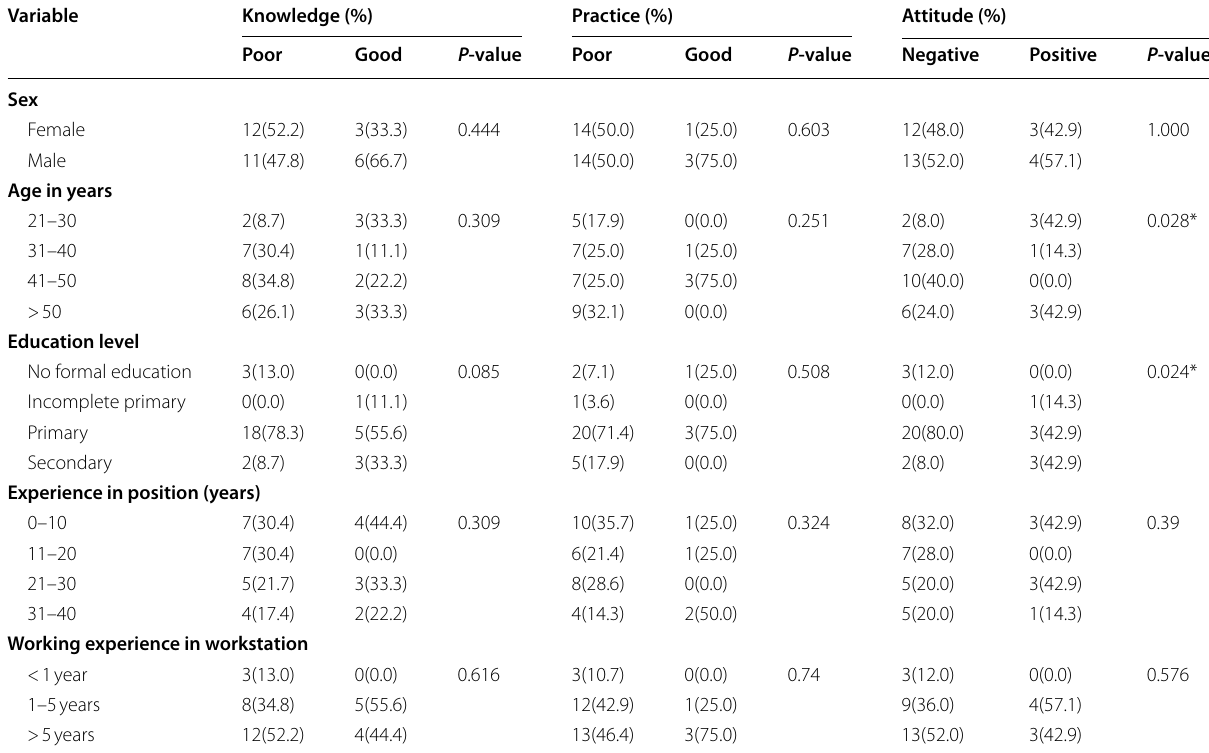
Table 3 Association between sociodemographic factors and the mean score in knowledge, practice and attitude of the community health workers ( N 32) =